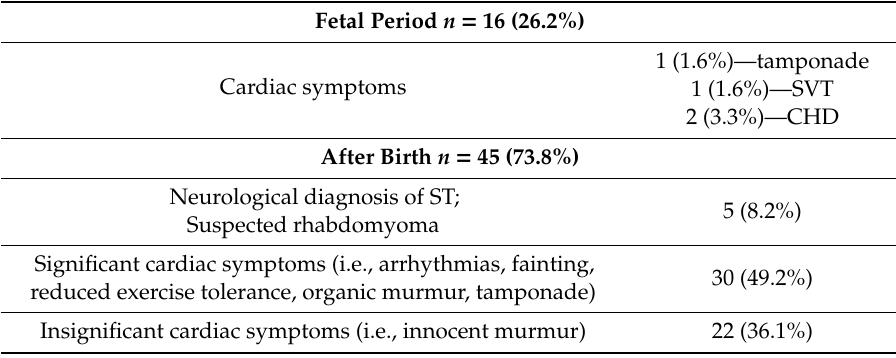
Table 2. Reasons for cardiologic consultations in children with heart tumors.